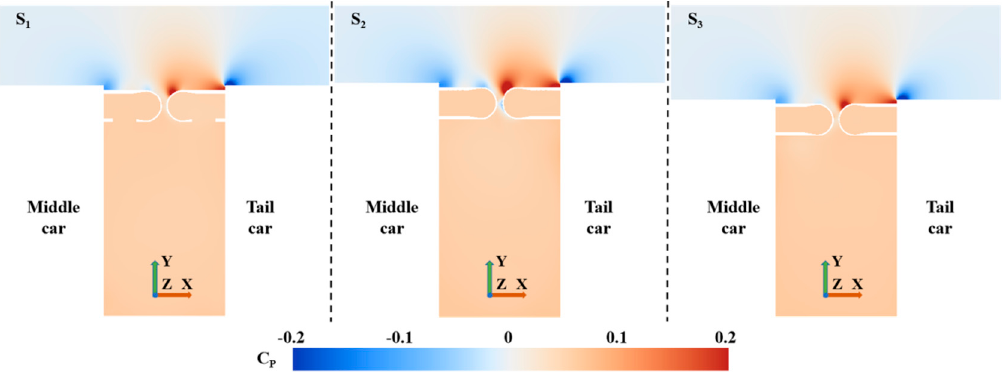
Figure 8. Average pressure distribution at the cross-section under the initial flow field.